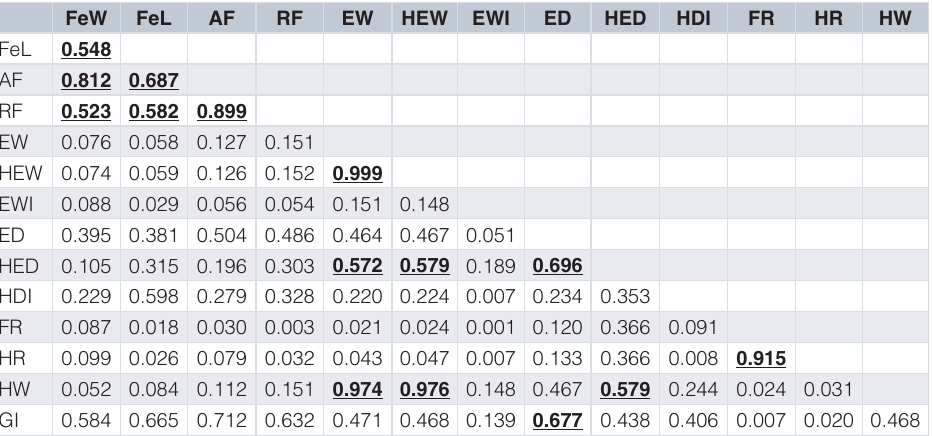
Table 3. Correlations of variables ( r 2 ) for Hemibagrus wyckii